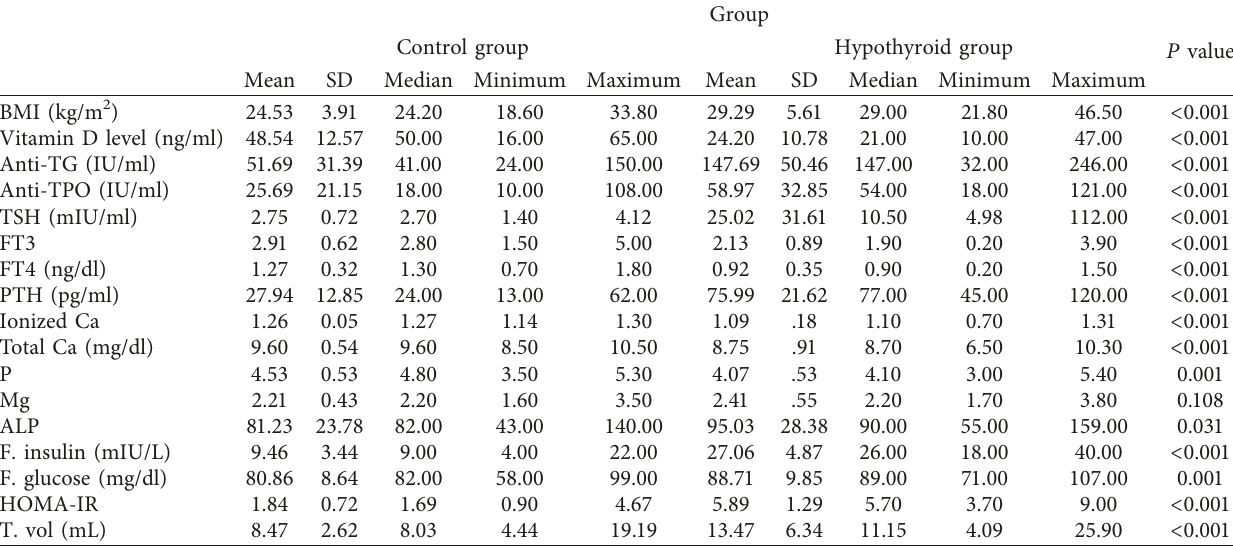
Table 1: Clinical and laboratory data of the two studied groups.